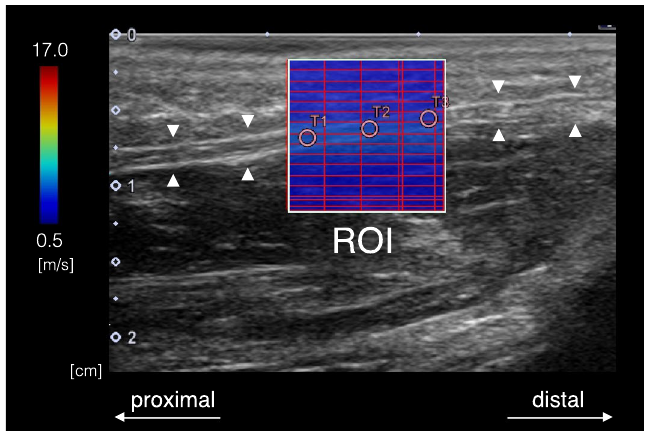
Figure 2. Representative shear wave image of the local SWV distribution of the aponeurosis in the square region of interest (RoI; 10 mm × 10 mm) (white grid). The PA is indicated by white triangles. The scale for the color code is provided to the left as SWV. SWV was calculated within three circles with a diameter of 1.25 mm equally positioned along the aponeurosis per one shear wave